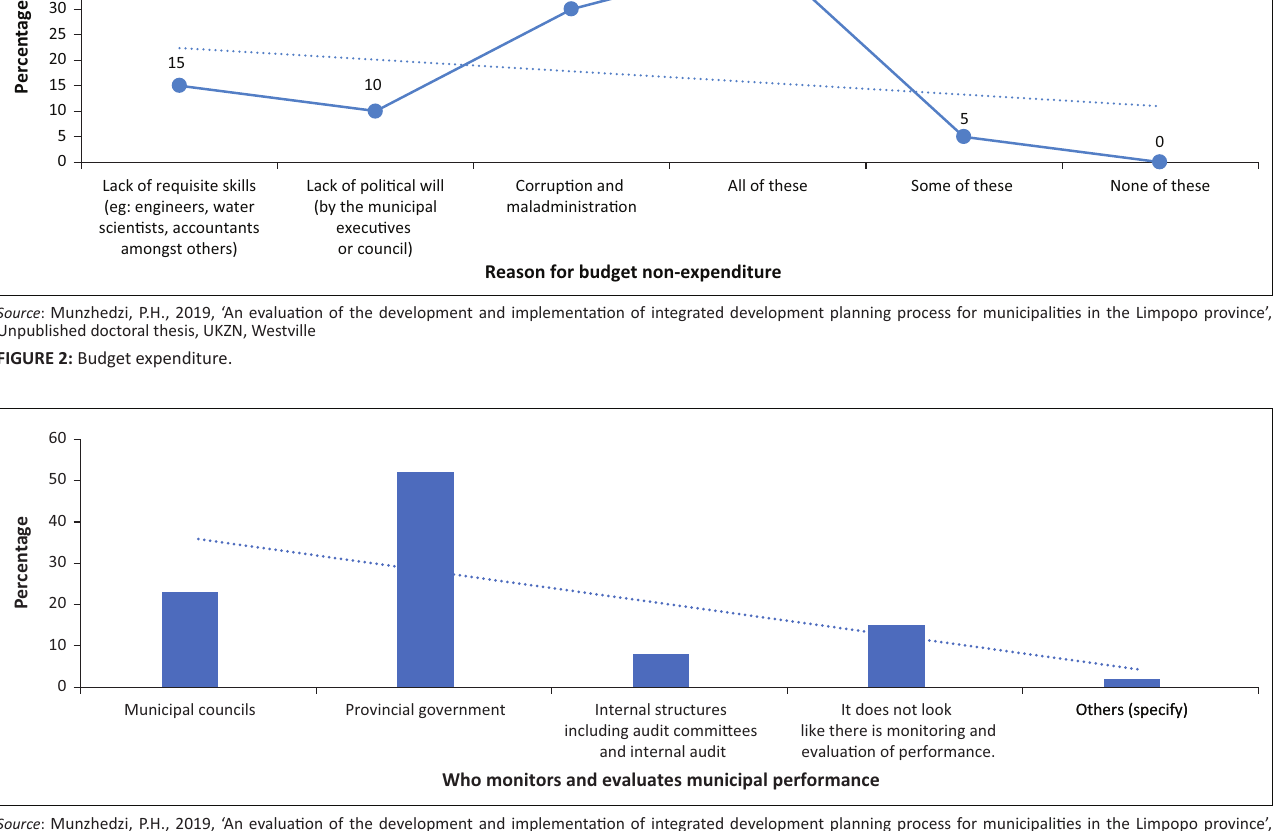
FIGURE 3: Monitoring and evaluation of municipal